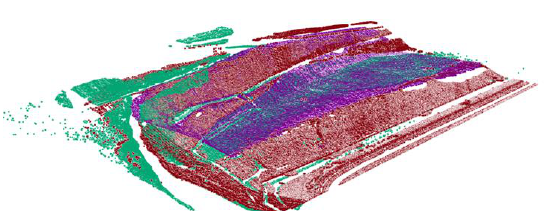
Figure 11. Mobile laser scanning data before merging process